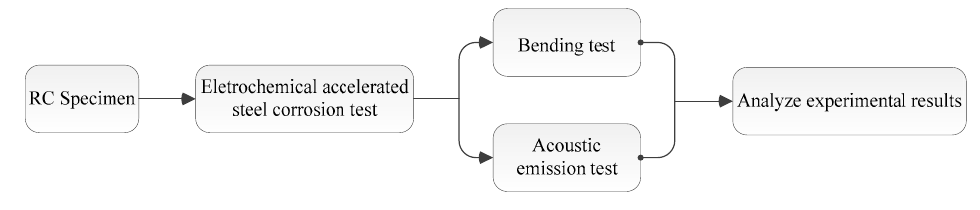
Figure 2. Experimental procedure.